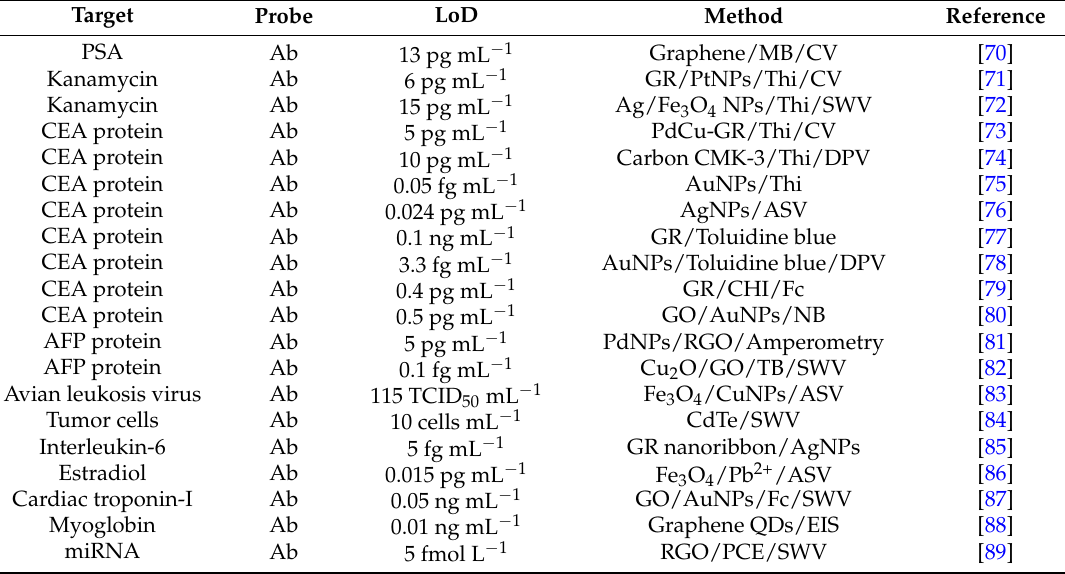
Table 5. Figures of merit of selected enzyme-free immunosensors using graphene and immobilized redox